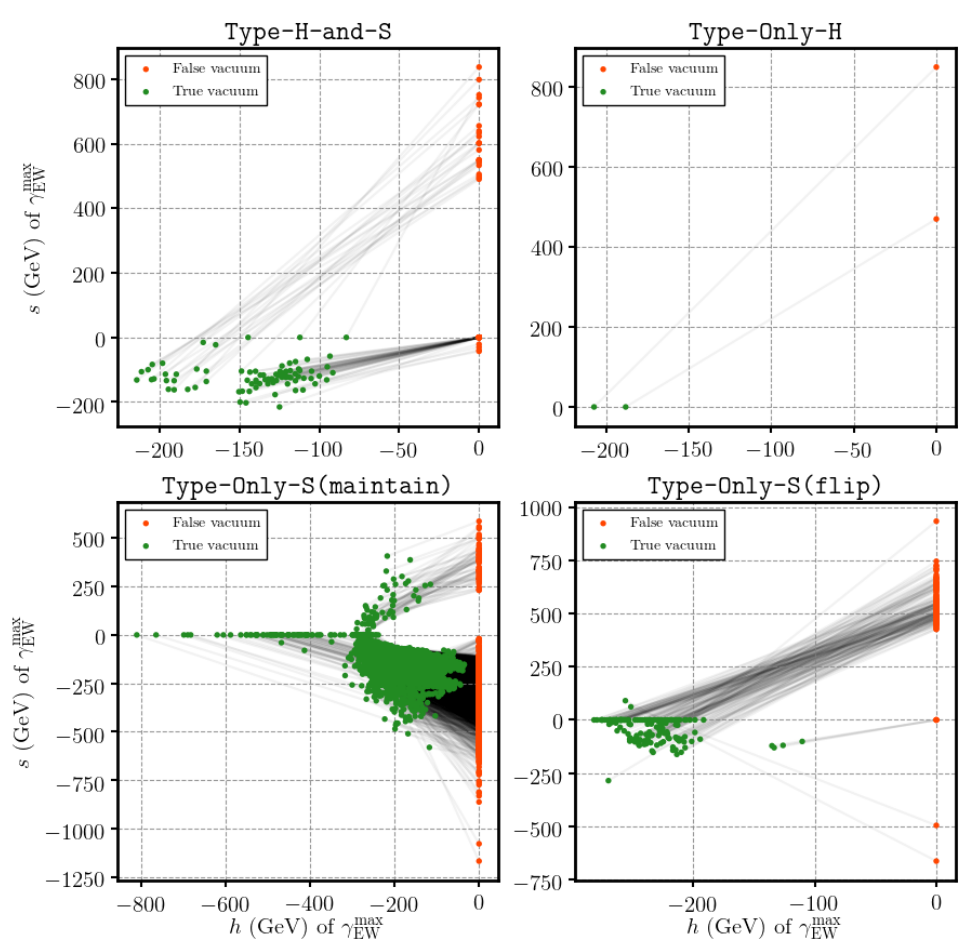
Figure 7 . The Higgs and singlet (cid:12)elds at the critical temperature of the strongest FOPT for samples for which the strongest FOPT does not end in the SM